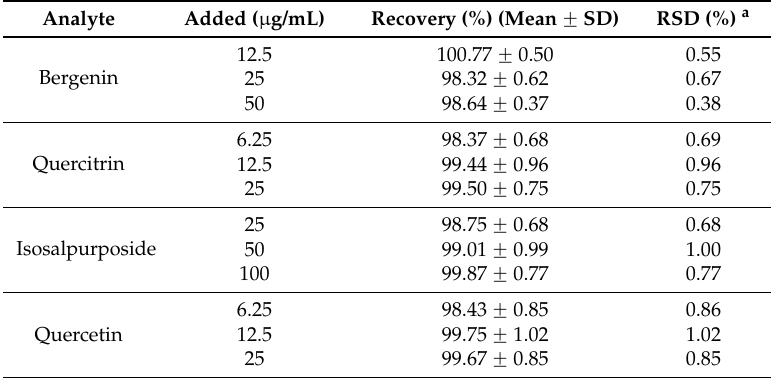
Table 4. Analytical data of recovery ( n =